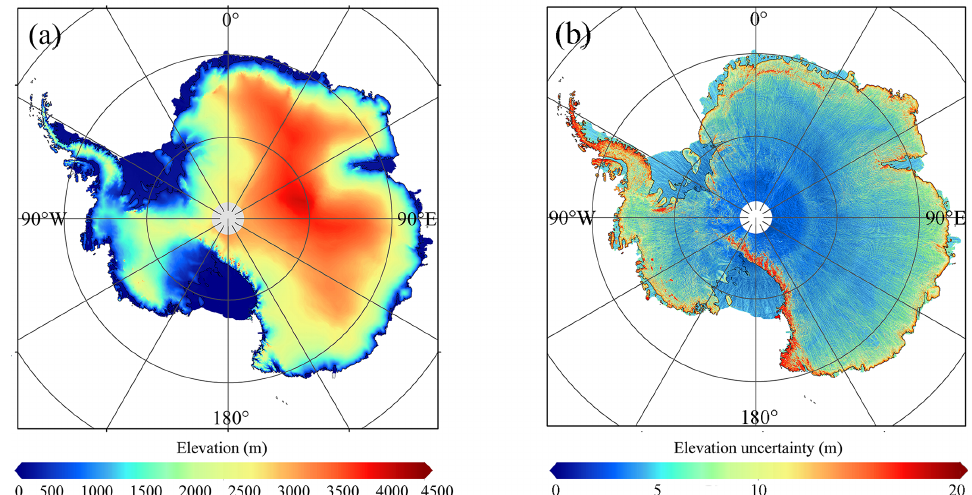
Figure 5. (a) A new DEM of Antarctica at a posting of 500m derived from ICESat-2, which covers both the ice sheet and ice shelves with the southern limit of 88 ◦ S. (b) Map of the ICESat-2 DEM elevation uncertainty.